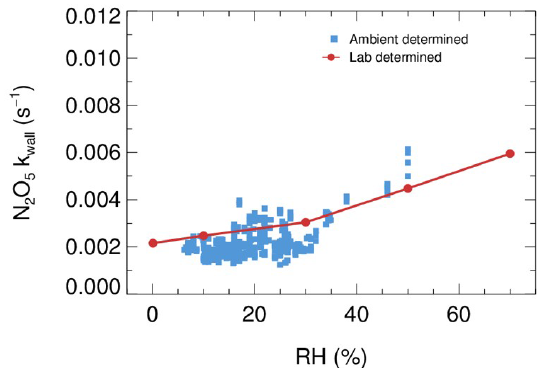
Figure B1. The derived dependence of N 2 O 5 wall loss on RH un- der laboratory conditions (red dots) and in field measurements (blue square).